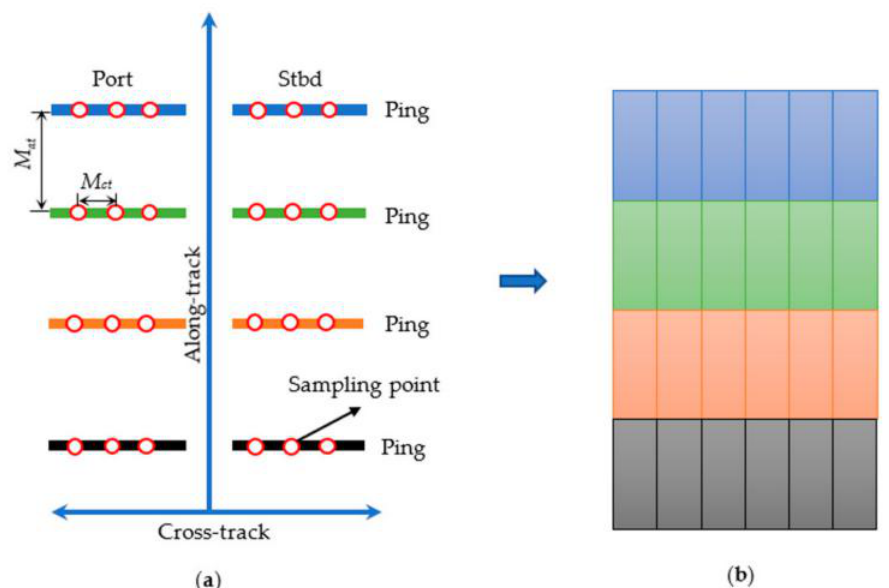
Figure 3. The distortion caused by the difference of mapping resolution in the along-track direction and cross-track direction: ( a ) is the schematic diagram of SSS measurement; ( b ) is the image generated from ( a ). The thick lines of four colors in ( a ) denote the scanning lines of SSS. M at and M ct denote the mapping resolutions in the along-track direction and cross-track direction, which are equal to the height and width of the grids in ( b